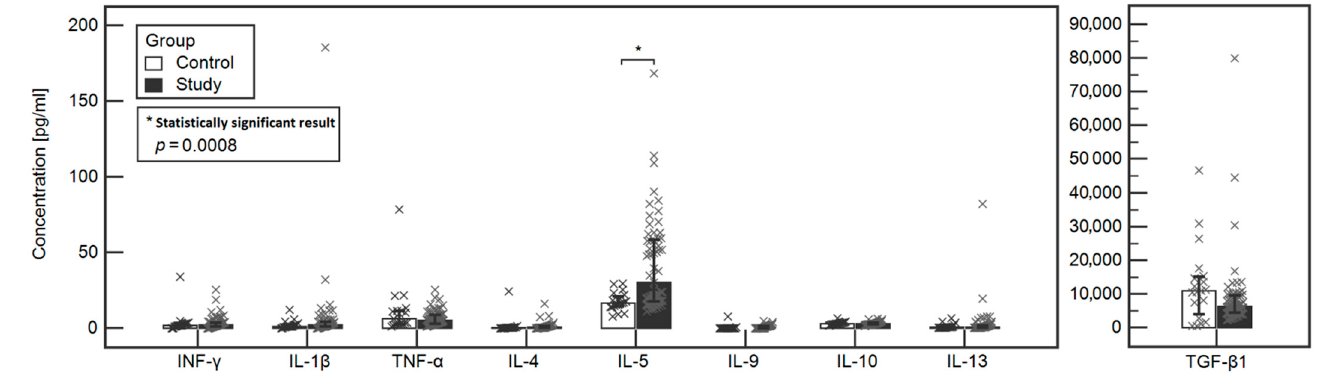
Figure 1. Comparison of the levels of tested cytokines between the study and control groups. Correlations between selected demographic and clinical variables and cytokines as- sessed in blood serum in the study group were examined. There was a weak negative correlation between INF- ɣ concentration and the number of miscarriages (rho = -0.296, p = 0.0204, Figure 2). Weak positive correlations were found between Il-5 and the number of miscarriages (rho = 0.264, p = 0.0394; Figure 3). Detailed data on Spearman’s rank correlation between selected demographic and clinical variables and cytokines in the study group are provided in Table 3.